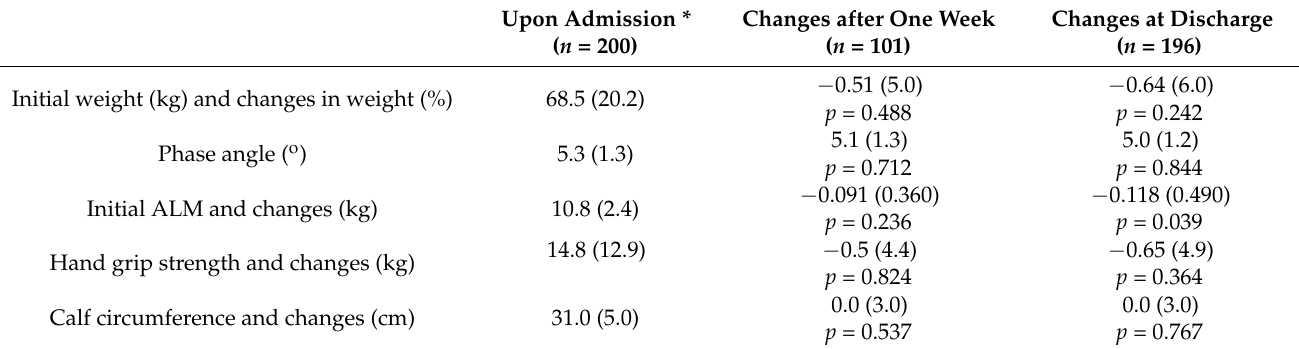
Table 4. Changes in muscle mass and function during